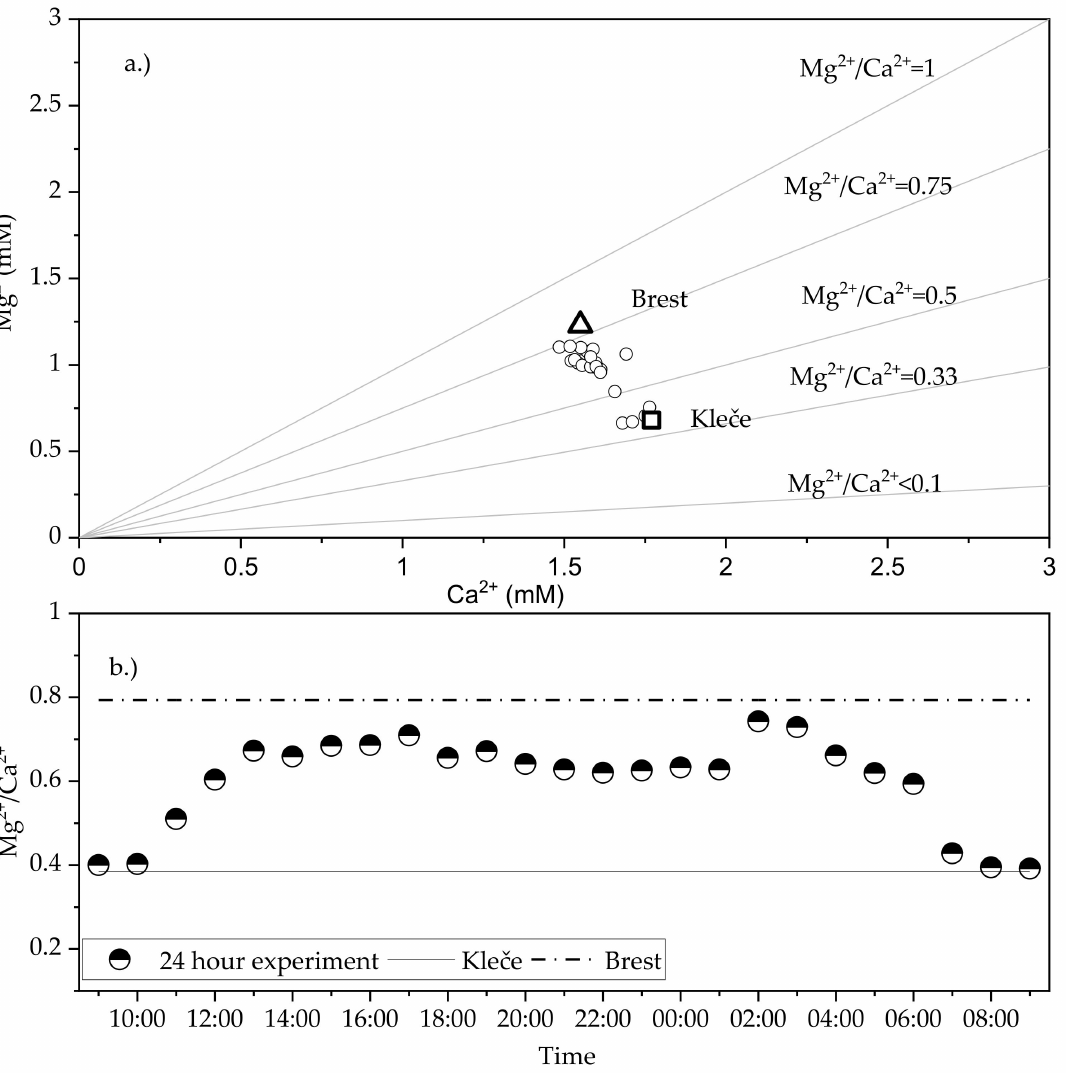
Figure 6. ( a ) Mg 2+ versus Ca 2+ concentration in tap water samples collected during the 24 h experiment. For comparison, average concentrations for wellfields Kleˇce (calcite prevails) and Brest (dolomite prevails) are shown. ( b ) Temporal changes in Mg 2+ /Ca 2+ values in tap water during the 24 h